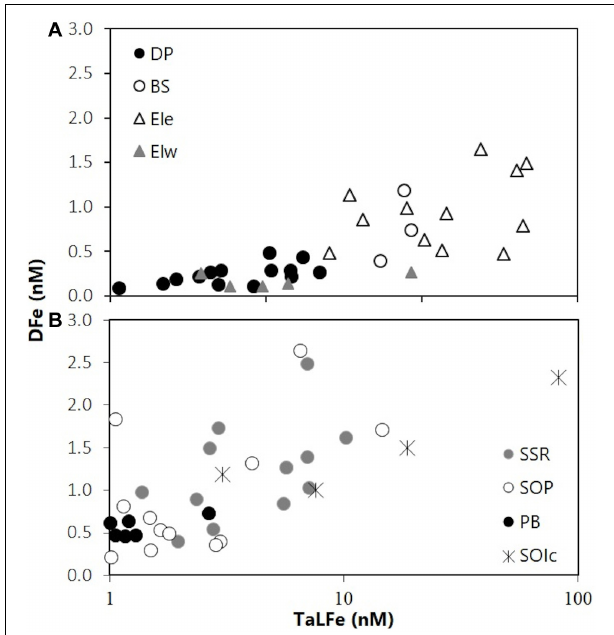
FIGURE 4 | TaLFe:DFe ratio for all groups of stations in (A) the SSI 2007 and (B) the SOI 2008 (note logarithmic scale).